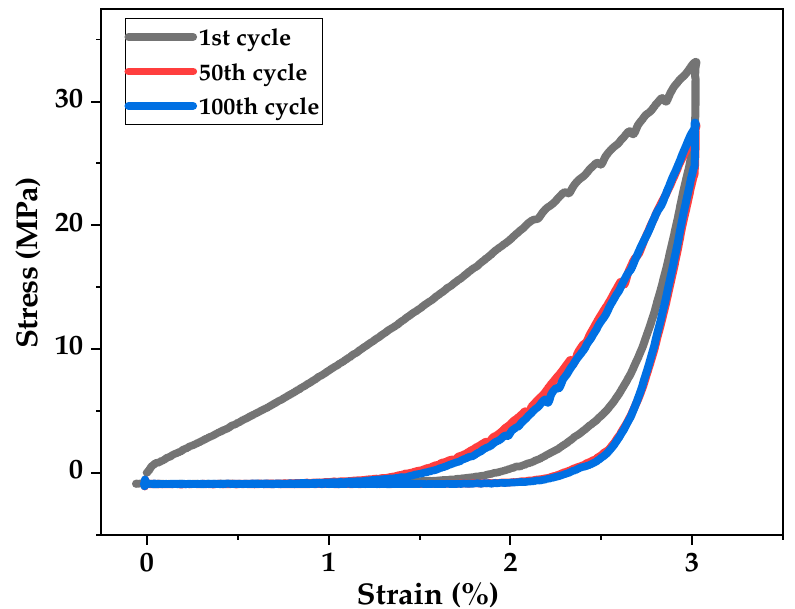
Figure 7. Mechanical hysteresis up to 3% strain for 1st, 50th and 100th cycles of sensor yarn with four coated layers of PEDOT:PSS.